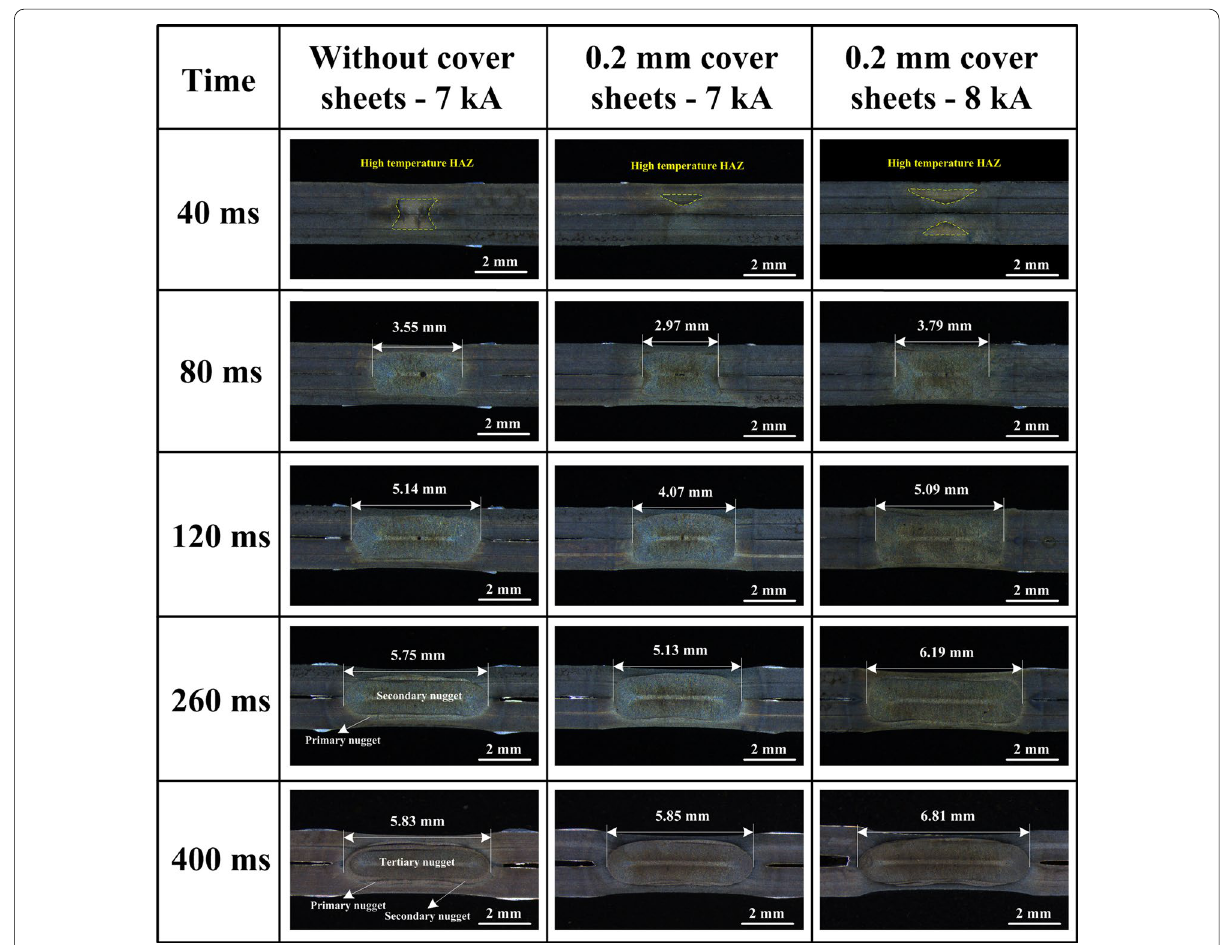
Figure 7 Nugget formation process under 7 kA without cover sheets and 7 kA and 8 kA with 0.2 mm cover